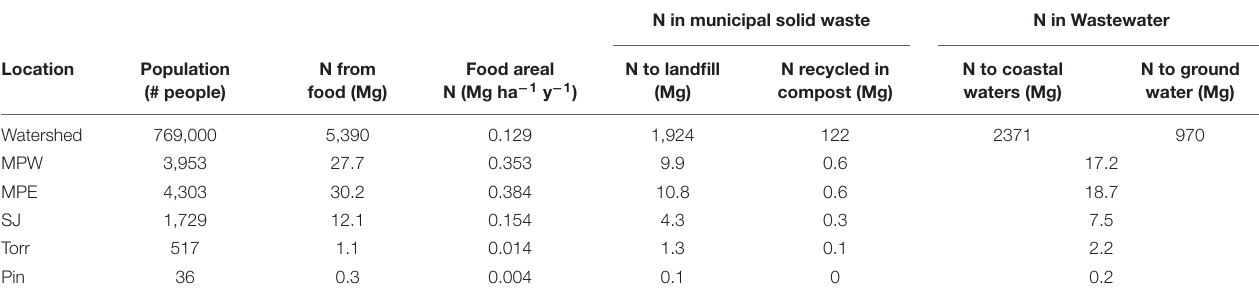
FIGURE 5 | Interpolated mangrove forest nitrogen storage (top) and accumulation rates (bottom) for both aboveground biomass and belowground soil ( ∼ 28 cm depth) components in the San Juan Bay Estuary. Map values represent distance weighted interpolations between known measurements at site locations. Bar graphs represent sums of all mangrove areas across the SJBE watershed. Aboveground mangrove sites (Branoff and Martinuzzi, 2020) are denoted by squares and belowground sites (this study) by circles. TABLE 3 | Nitrogen (N) inputs as food to the San Juan Bay Estuary watershed (area: 41,572 ha) and its fate. N in municipal solid waste N in